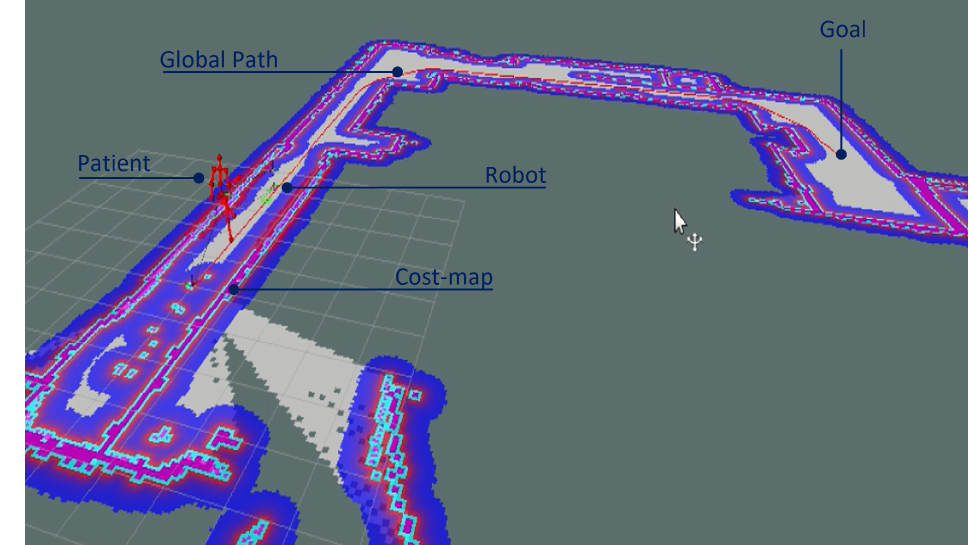
Figure 1. Robot–person–environment interactions in a typical setup in the development of this